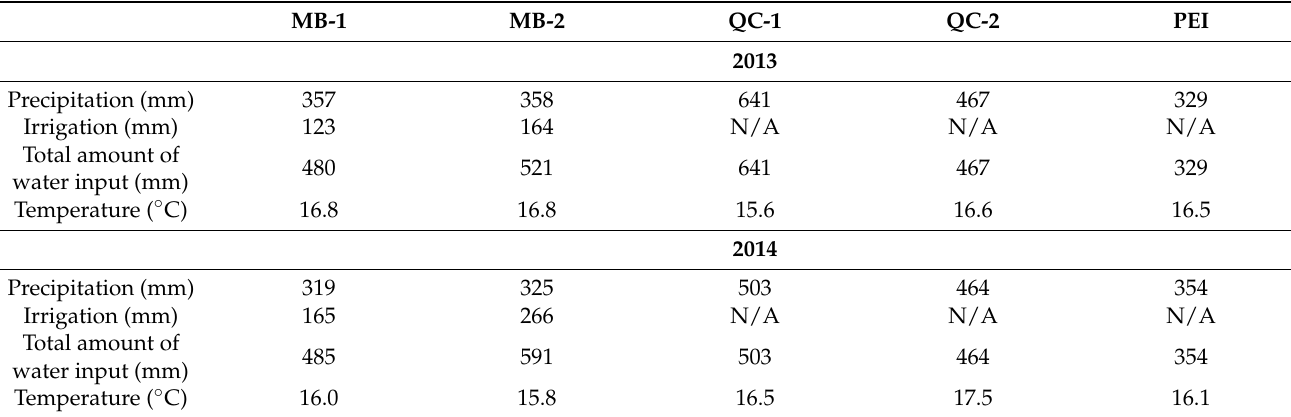
Table 3. Total amount of water input from planting to harvest and mean temperature during the growing seasons (May– September) measured at different sites in comparison with the 30-yr